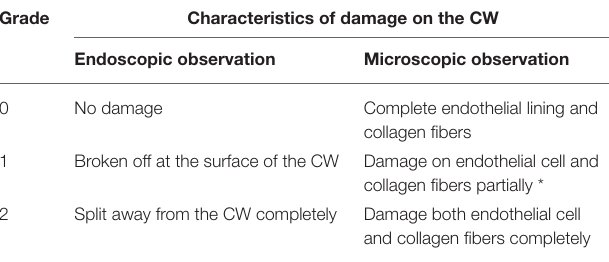
TABLE 1 | Simple damage classification system of CW during mimicking mechanical thrombectomy in the